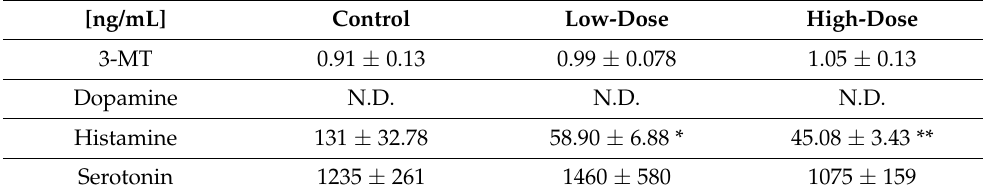
Table 5. The concentration of monoamines in the plasma. [ng/mL] Control Low-Dose High-Dose 3-MT 0.91 ± 0.13 0.99 ± 0.078 1.05 ± 0.13 Dopamine N.D. N.D. N.D. Histamine 131 ± 32.78 58.90 ± 6.88 * 45.08 ± 3.43 ** Serotonin 1235 ± 261 1460 ± 580 1075 ±